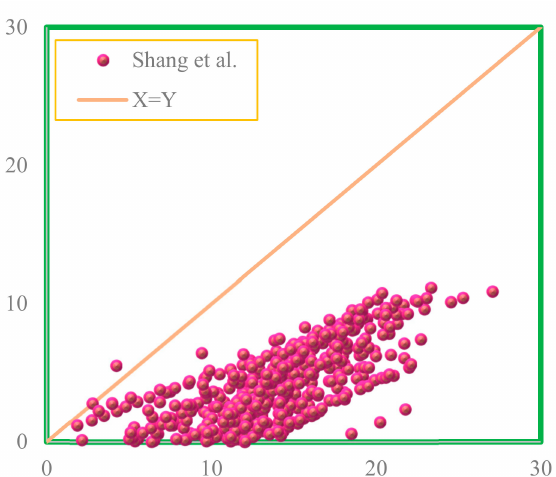
Figure 4. Cross plot of the model existing in the literature for IFT